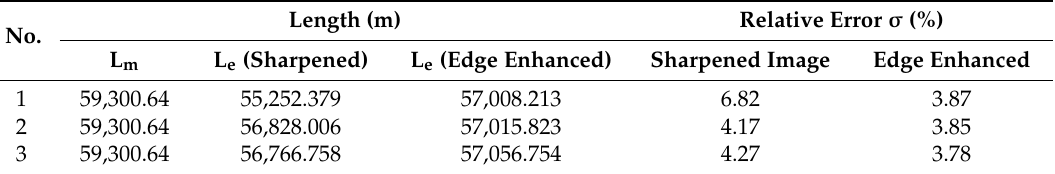
Table 4. Result of extracted length verification.